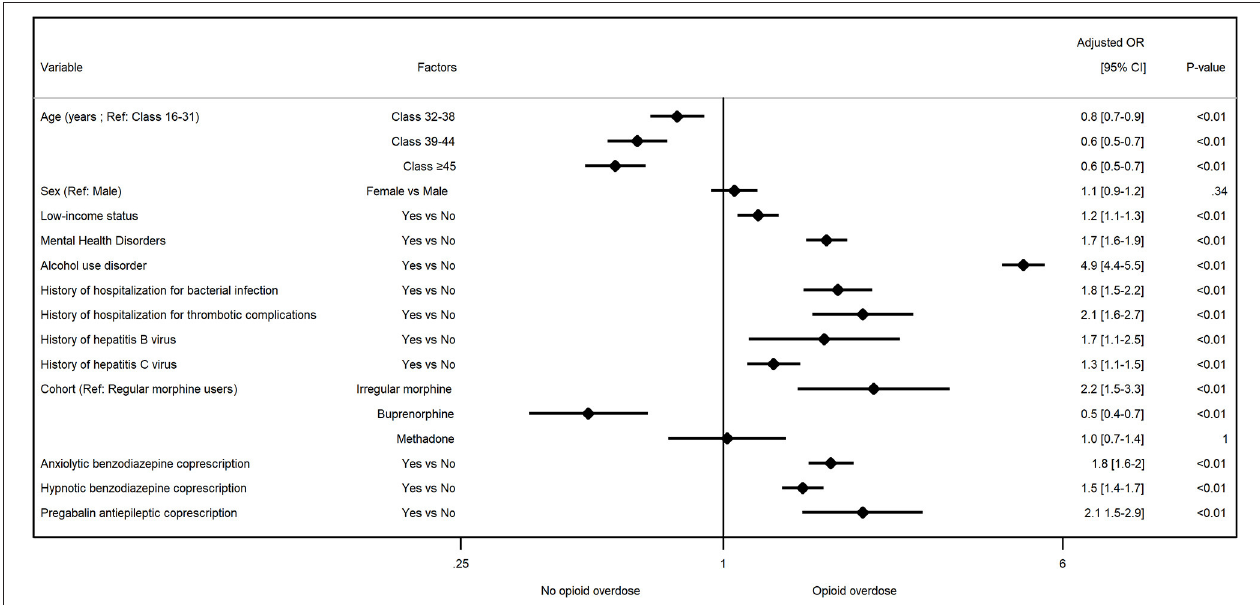
FIGURE 2 | Factors associated with opioid overdose in opioid use disorder patients in multivariate analysis. aOR, adjusted odd ratio.